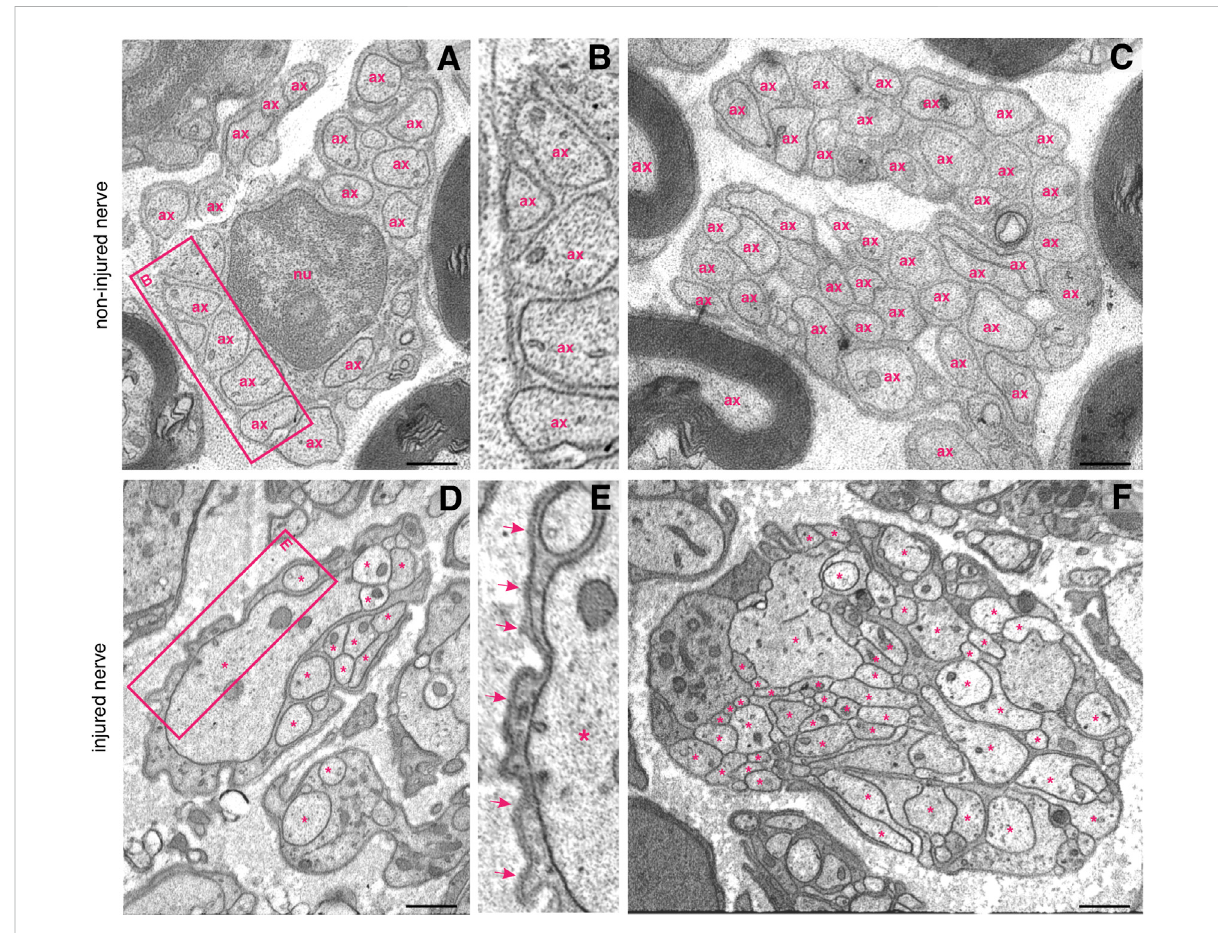
FIGURE 3 Ultrastructure of non-myelinated fi bre bundles in a non – injured nerve and in a regenerating proximal nerve stump. (A) Multiple non – myelinatedaxons (ax) hostedby anon – myelinating Schwann cell. Each axon is wellseparated from theothers (B) and more than 40 axons can formaso – called “ Remakbundle ” (C) ;nu — nucleus. (D) Asinglenon-myelinatingSchwanncellusesitslamellipodiatoaccomodateaxonalsproutsof different calibres (asterisks), but no myelination occurs. Note the difference between the Schwann cell basal lamina of the intact (B) and an injurednerve (E) ,arrowsindicatetheelectron-densebasallamina. (F) Morethan50irregularlyshapedaxonalsprouts(asterisks)canbetightlypacked within a non – myelinating Schwann cell. The Schwann cell pseudopodia appear electron – denser than sprouts. Staining: osmium tetroxide, potassium (III) hexacyanoferrate and post – contrasting with lead nitrate and uranyl acetate. Specimen: 55 – nm – thin sections of resin – embedded proximal nerve stumps, 10 days after transection performed in C57Bl6/J mice. Scale bar, 500